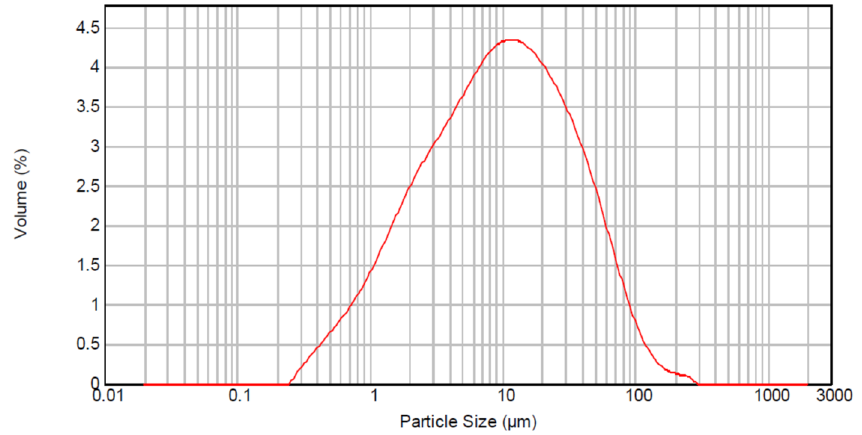
Figure 4. Particle size distribution of the feed samples used in present study.